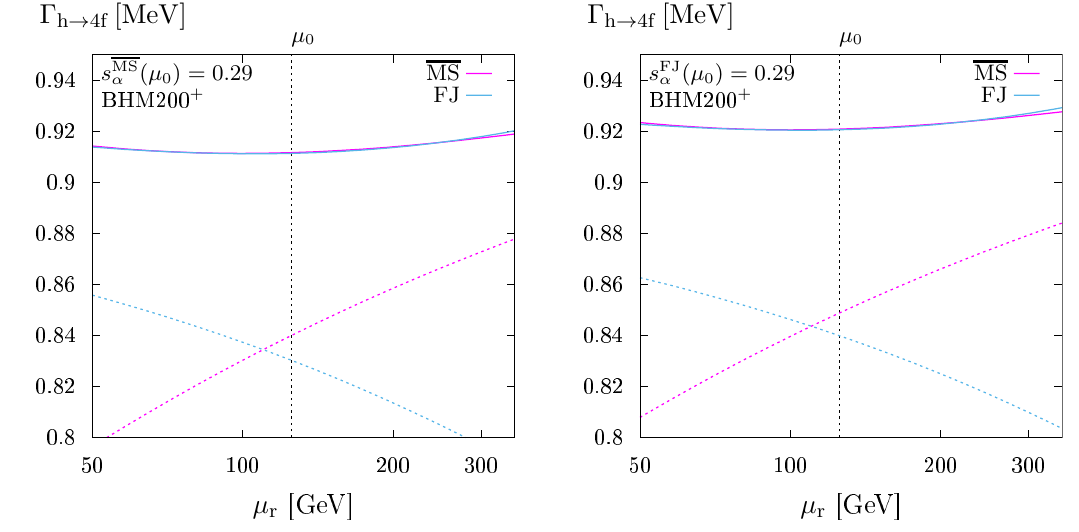
Figure 11 . Scale dependence of the decay width (cid:0) h ! 4 f at LO (dashed curves) and NLO EW+QCD (solid curves) for benchmark scenario BHM200 + , using the central scale (cid:22) 0 = M h . On the left (right) the input parameters are de(cid:12)ned in the MS (FJ) scheme and converted to the FJ (MS) scheme at the scale (cid:22) 0 (both for LO and NLO